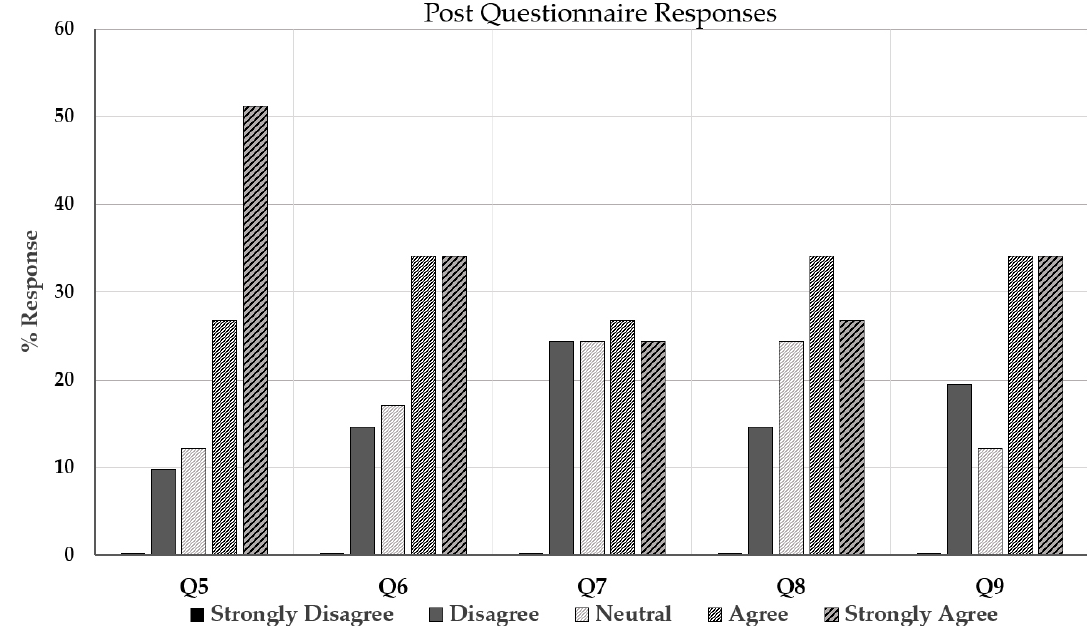
Figure 5. Student responses to questions Q5: Drug chemical structures are easy to understand and memorize using the MedChem VR game; Q6: I think the MedChemVR learning tool is flexible enough for training; Q7: Understanding the structure-activity relationship (SAR) from the drug chemical the structure is easy; Q8: Visualizing and deriving conclusions from a drug’s structure is easy; Q9: I can easily recognize and navigate through the 3D structure of drugs from different perspectives.